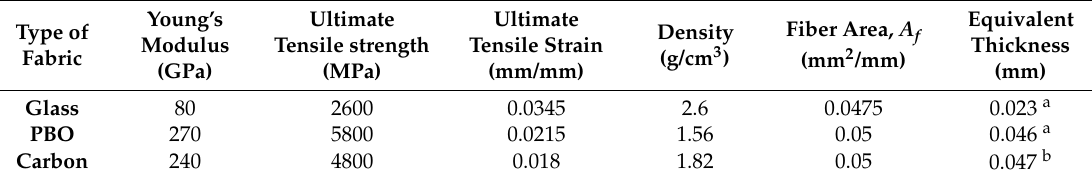
Table 2. Details of the fibers used in the FRCM